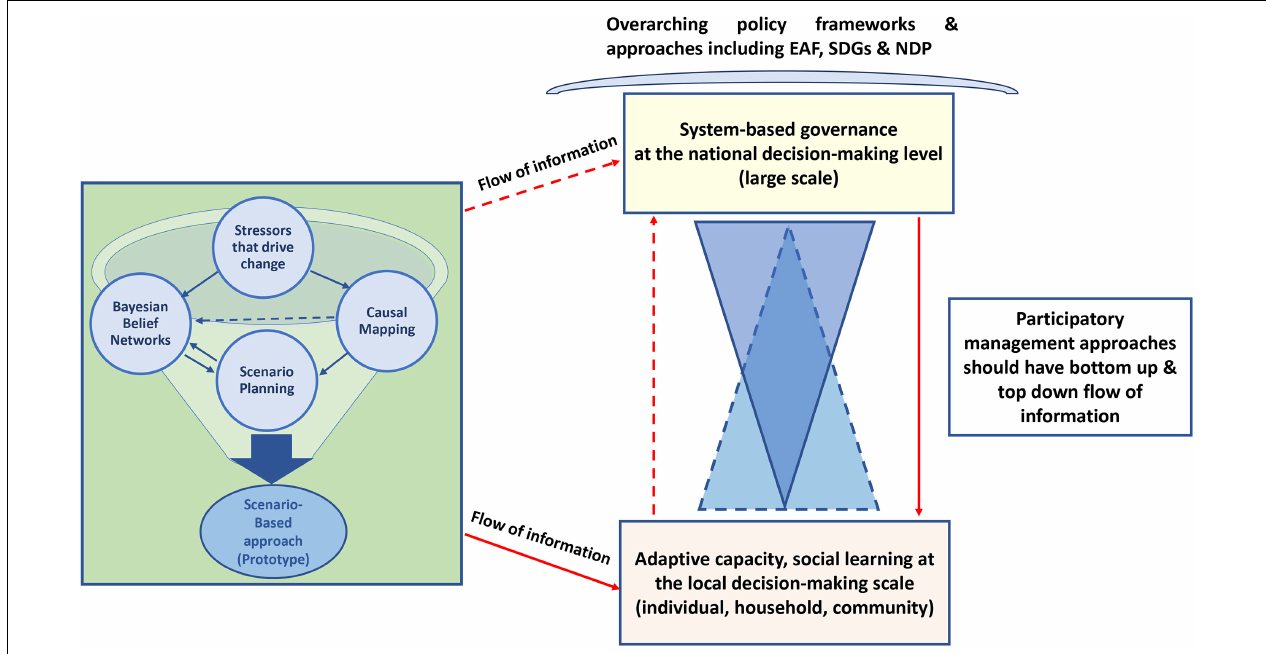
FIGURE 2 | Overall framing of the research. From left to right - this prototype scenario-based approach to management employs various decision-making tools to generate both quantitative and qualitative knowledge. For this case study (shown by the solid red lines which are ‘flow of information’), the knowledge generated through the implementation of the tools contributes to capacity building (enhancing adaptive capacity) and more informed decision-making by the individual/household or community at the smaller scales of operation. While top-down interactions (scaling down) are functional in the current management paradigm (shown by the inverted triangle), practical mechanisms to facilitate bottom-up interactions are ill-defined or non-existent. The implementation of the approach identifies a method that facilitates the multi-directional flow of information (shown by broken lines) in the pursuit of the implementation of an EAF together with other over-arching policy goals such as Agenda 2030.